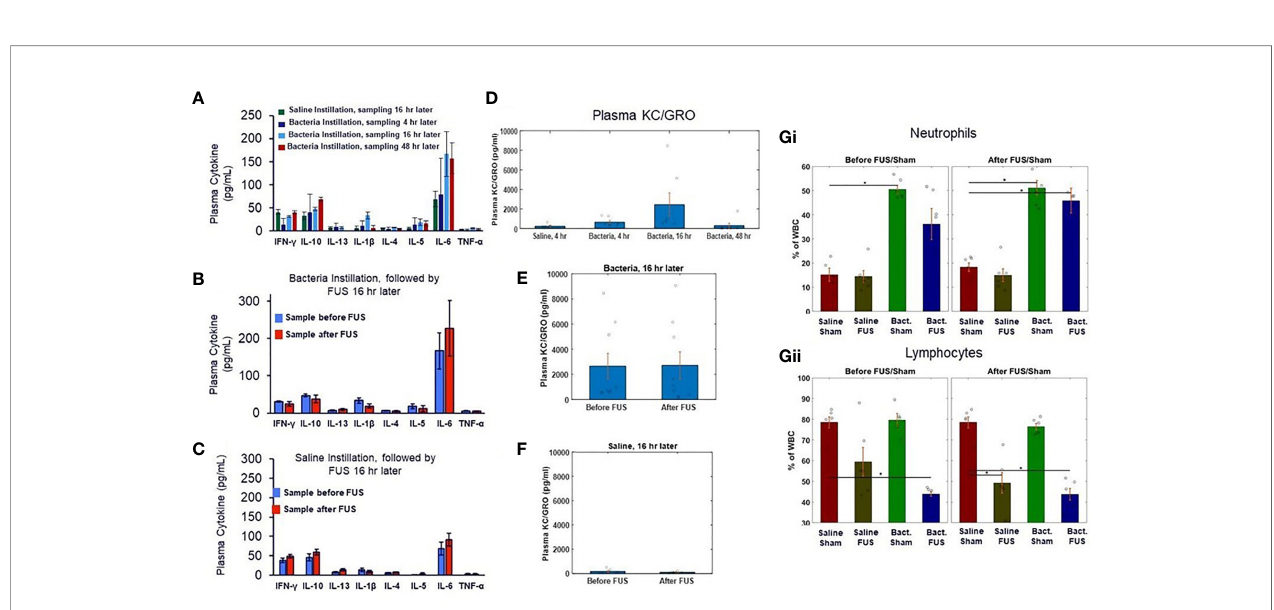
FIGURE 3 | Plasma cytokine levels and blood cell counts after saline and bacterial instillation. (A) Plasma cytokines levels in pre- ultrasound/sham samples in control and bacteria instilled animals at 4 hours, 16 hours, and 48 hours timepoints. (B) Plasma cytokines levels in pre- and post- ultrasound samples in bacteria instilled animals at 16 hours timepoint. (C) Same as (B) , but in saline instilled animals. (D) Plasma chemokine KC/GRO levels (a neutrophil chemokine) in control (no bacteria) and bacteria instilled animals at 4 hours, 16 hours, and 48 hours timepoints. (E) Plasma chemokine KC/GRO levels in bacteria instilled animals before and after ultrasound stimulation at 16 hours timepoint. (F) Same as (E) , but in saline instilled animals. (Gi) Percentage of white blood cell differentials in saline and bacteria instilled animals before ultrasound or sham stimulation at 16 hours. (Gii) Same as (Gi) , but after ultrasound or sham stimulation. Asterisk indicates p <0.05 using non- paramteric Wilcoxon rank sum